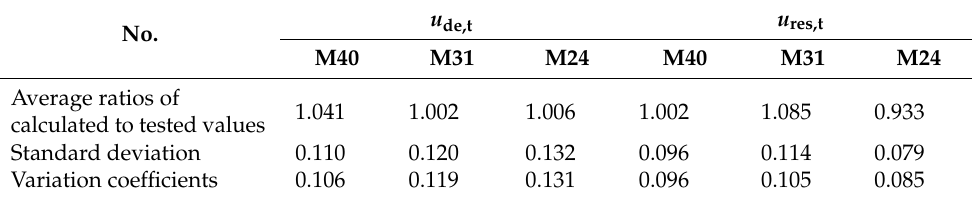
Table 6. Energy dissipation in the process of pull-out test. Item